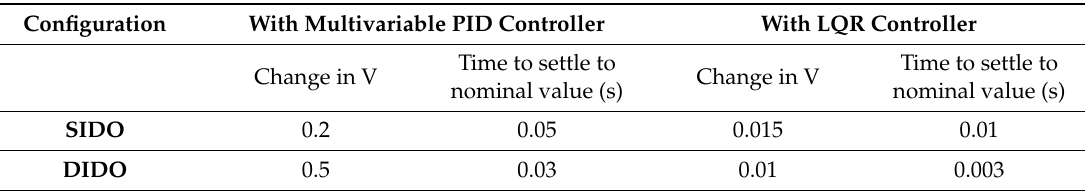
Table 3. Cross regulation analysis for multivariable PID and LQR controller.